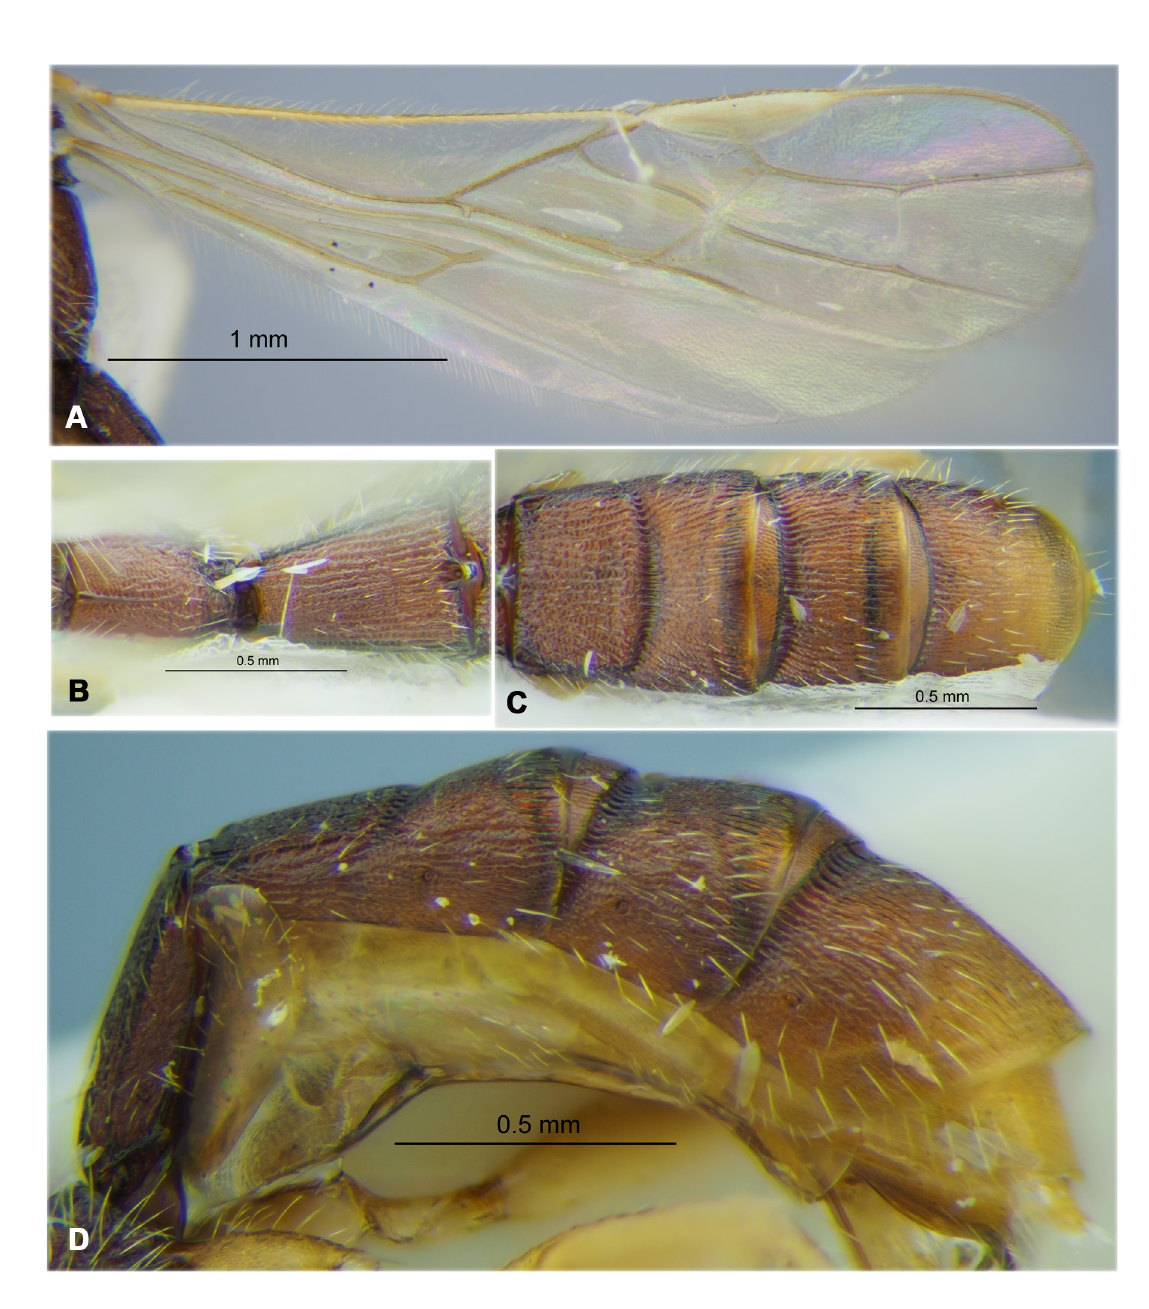
Fig. 54. Rhaconotus ( Rh. ) manolus Nixon, 1941, ♀ (RMNH). A . Wings. B . Propodeum and first metasomal tergite, dorsal view. C . Second to fifth metasomal tergites, dorsal view. D . Metasoma, lateral